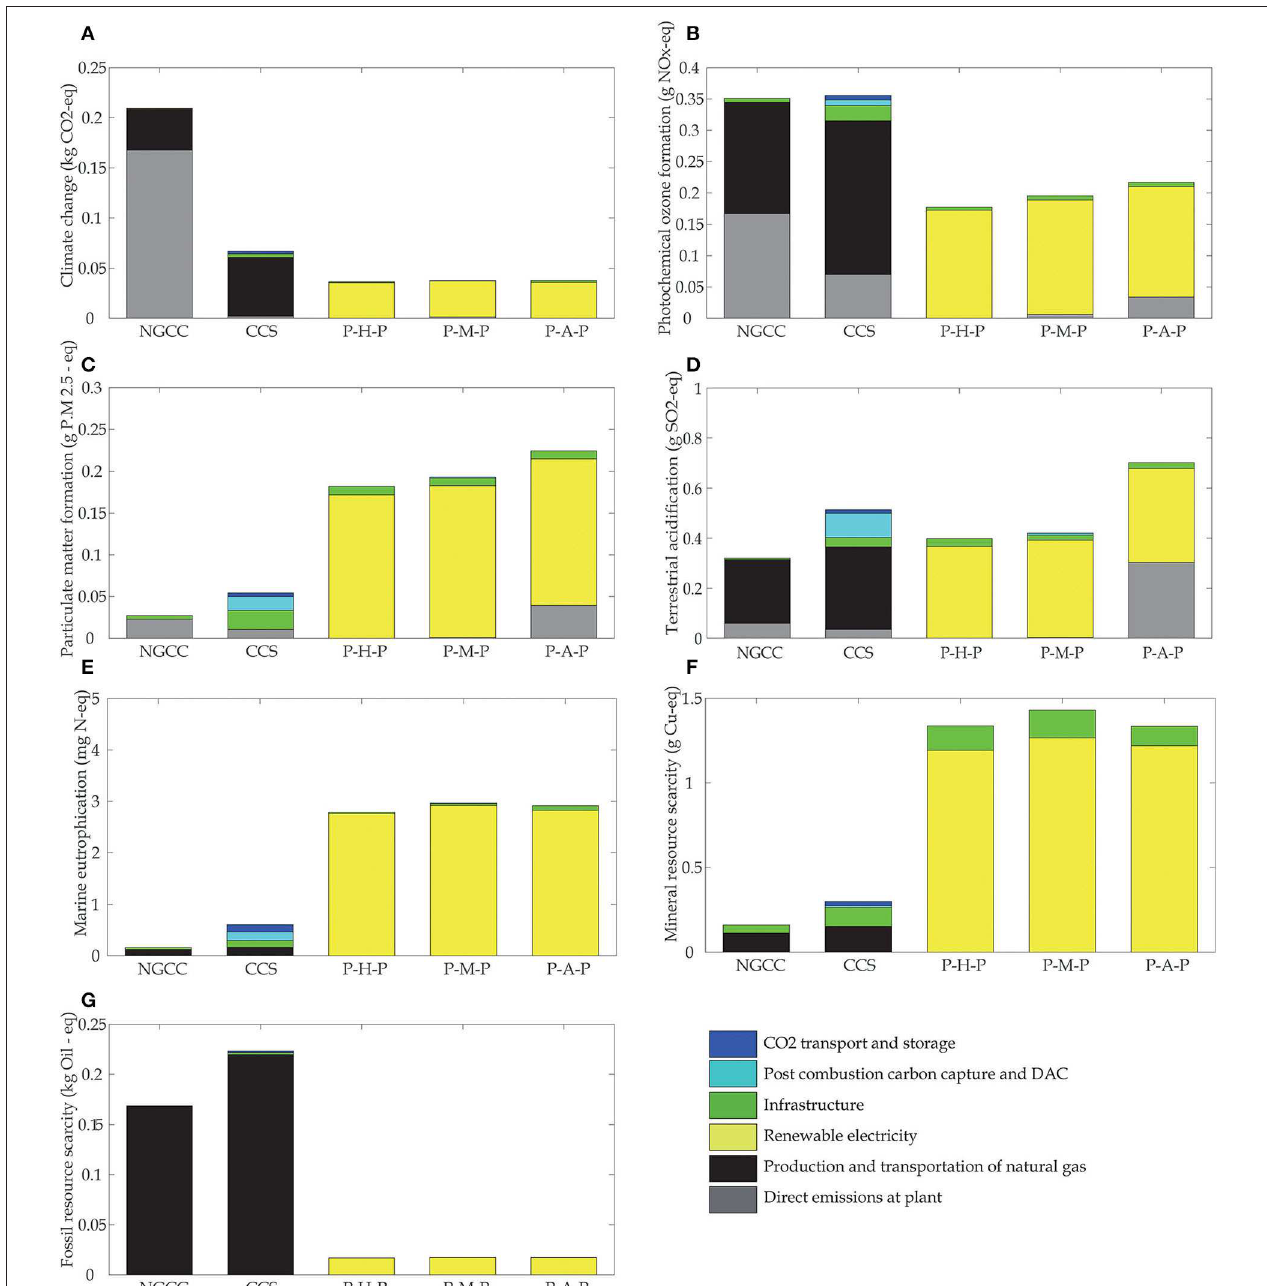
FIGURE 9 | Cradle-to-factory gate impacts of 1 kWh dispatchable electricity of the five studied product systems, breakdown by key processes. (A) Climate change, (B) Photochemical ozone formation, (C) Particulate matter formation, (D) Terrestrial acidification, (E) Marine eutrophication, (F) Mineral resource scarcity, and (G) Fossil resource